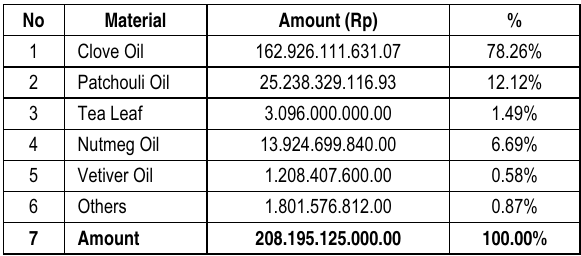
Table 2. Comparison of purchasing of natural